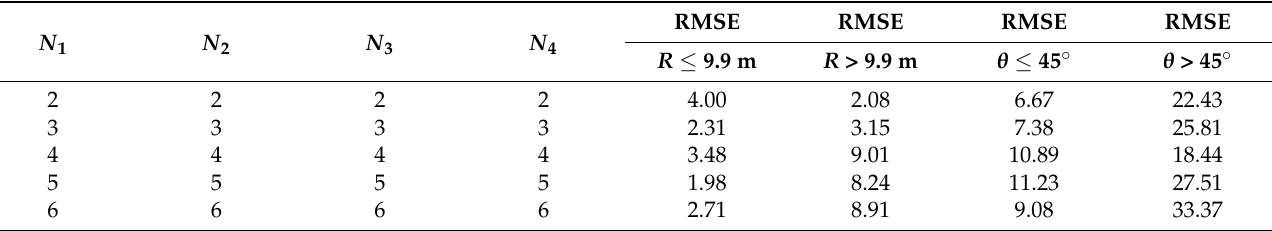
Table 2. Selection of piecewise polynomial